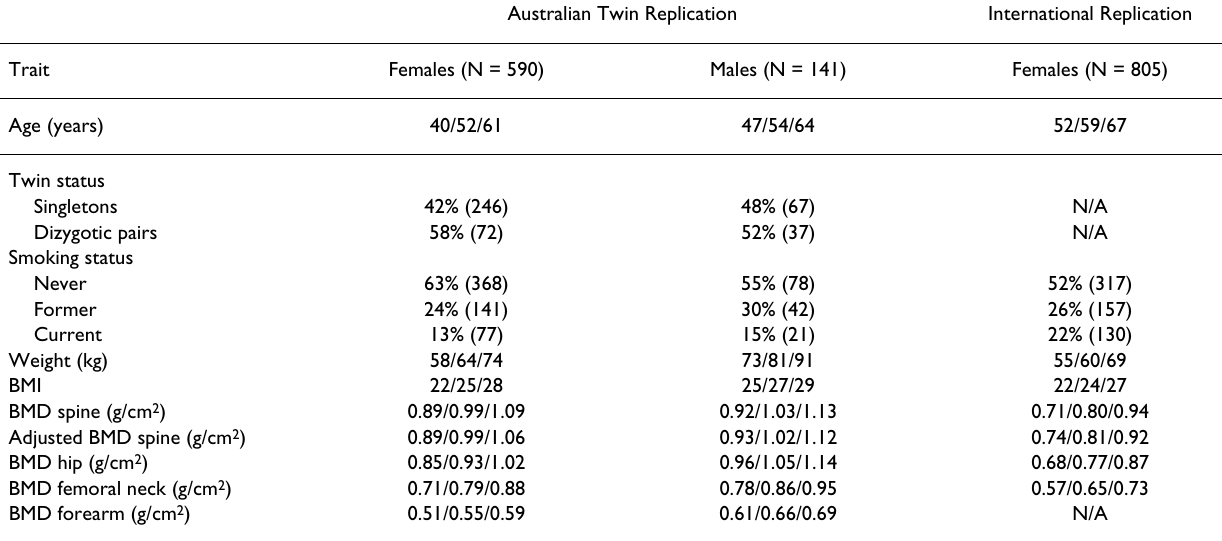
Table 3: Characteristics of complete genotyped replication